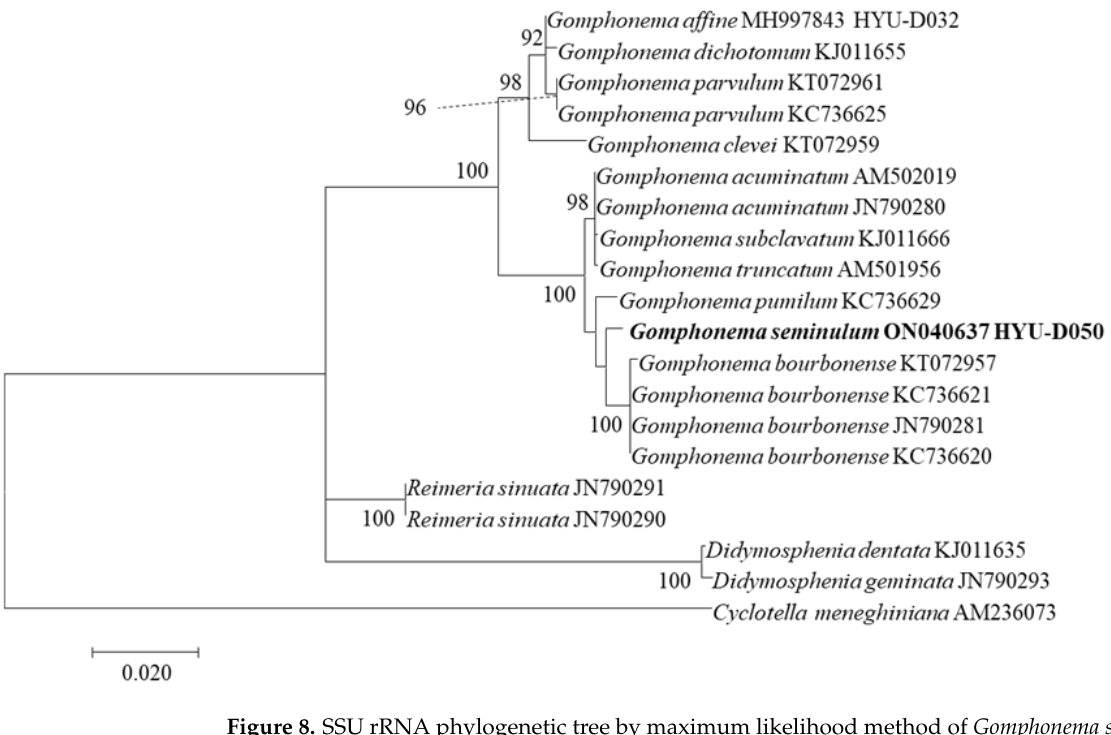
Figure 8. SSU rRNA phylogenetic tree by maximum likelihood method of Gomphonema seminulum sp. nov. and other species molecular position. The tree with the highest log likelihood ( − 3766.04) is shown. The percentages of trees in which the associated taxa clustered together are shown next to the branches. The analysis involved 20 nucleotide sequences and 1475 positions in the final data set. Cyclotella meneghiniana was used as the outgroup.